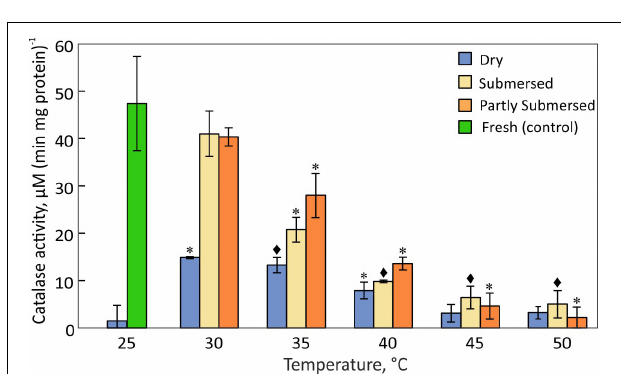
FIGURE 9 | Catalase activity in dried and fully or partly submersed Pleopeltis fronds exposed to different temperatures for 24 h. The activity of heat treated dry and hydrated fronds is compared with 25 ◦ C dry and fresh (control), respectively. Significant differences between treated and controls are indicated by * ( P ≤ 0.05) and (cid:7) ( P ≤ 0.001); means ± SE, n = 4.